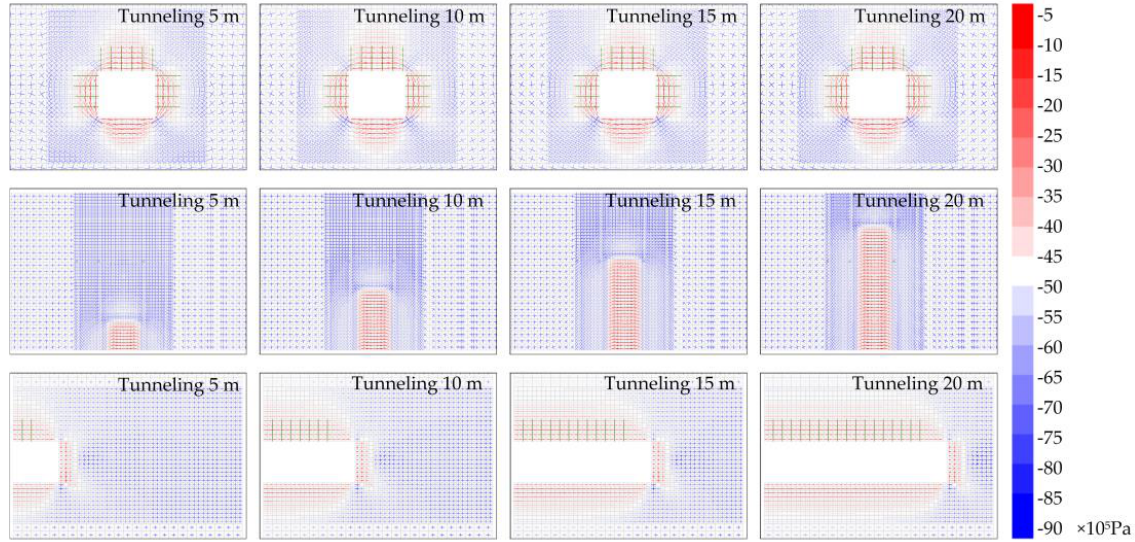
Figure 6. Distribution characteristics of principal stress tensor of heading face (stained with σ 1 ).